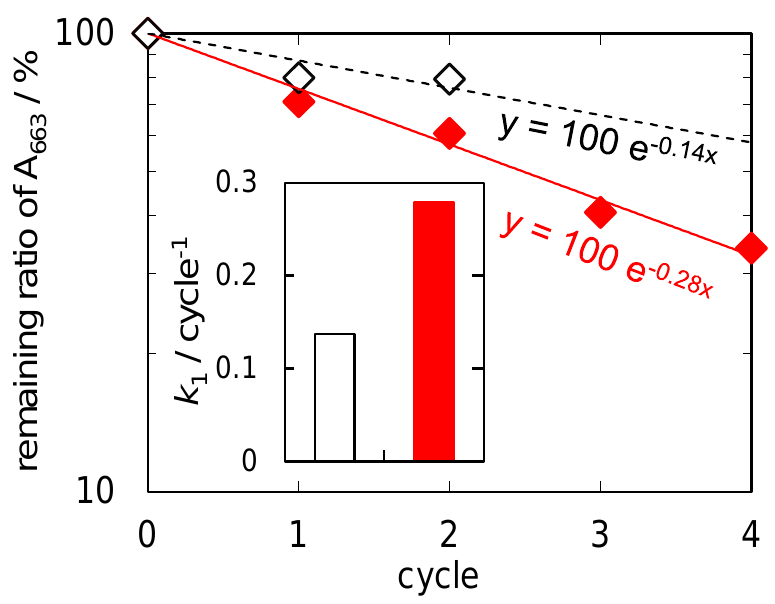
Figure 6. Plot showing the results of methylene blue decomposition test of porous TiO 2 -impregnated a-silica tube (red) and a-silica tube without TiO 2 impregnation (white). Inset: Reaction rate constants ( k 1 ) of the